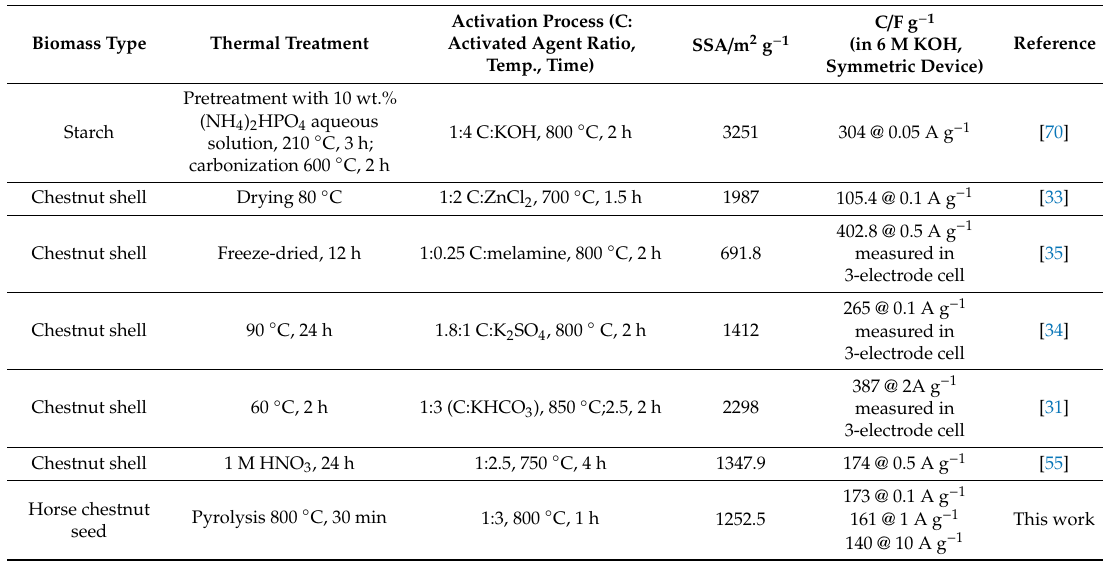
Figure S1. Specific capacitance values recorded for C-non ( a ) and C–CO 2 ( b ) samples at di ff erent current densities. Inset: GCD profiles at high current densities (1–10 A g − 1